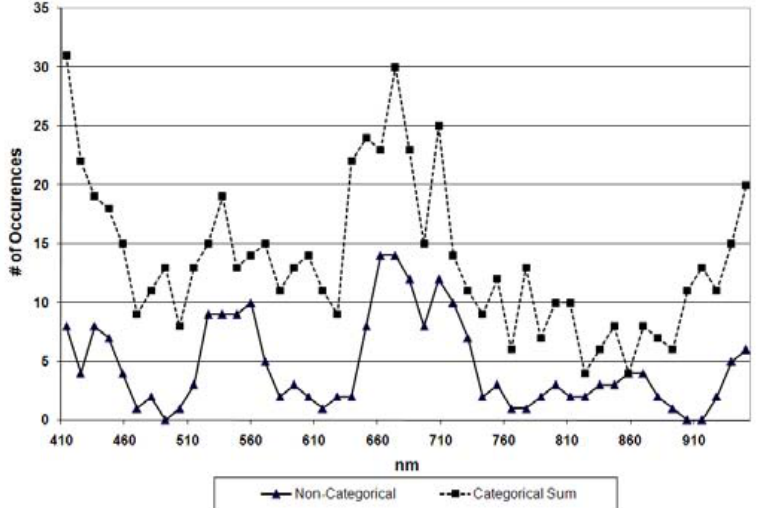
Figure 2 . The number of times each band had a top five positive or negative loading value derived from the combined covariance and correlation PCA of all the spectra combined vs